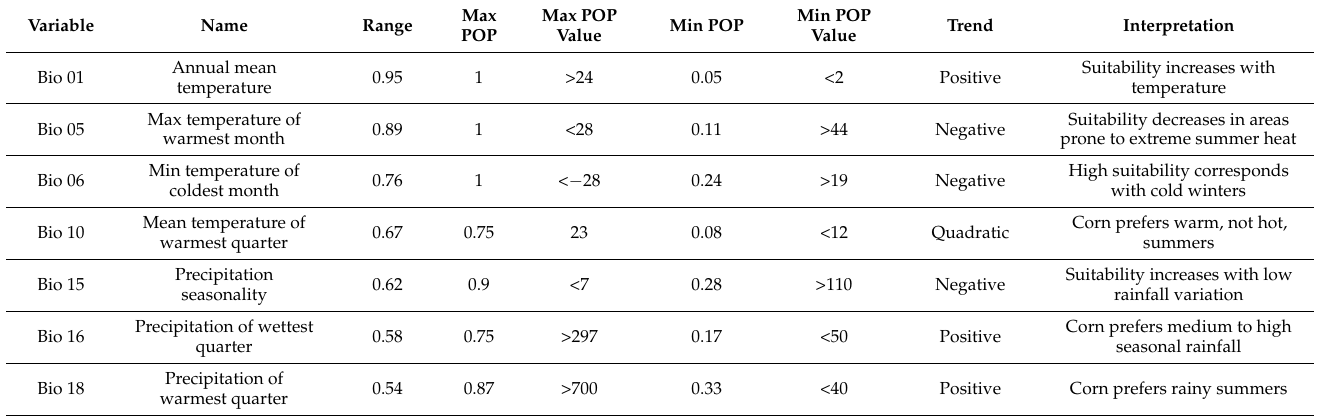
Figure 6. ( a – s ) Response curves for 19 bioclimatic variables. Response curves show how bioclimatic variable values correspond to suitability thresholds independently assuming all other variables are held static. Individual response curves show the suitable ranges and variation for each variable, and when considered together, suitable areas will be where multiple bioclimatic variables overlap to produce overall suitable conditions. Table 2. Bioclimatic variables with the greatest influence on the Maxent probability of presence (POP) results. Variables are listed in order of descending